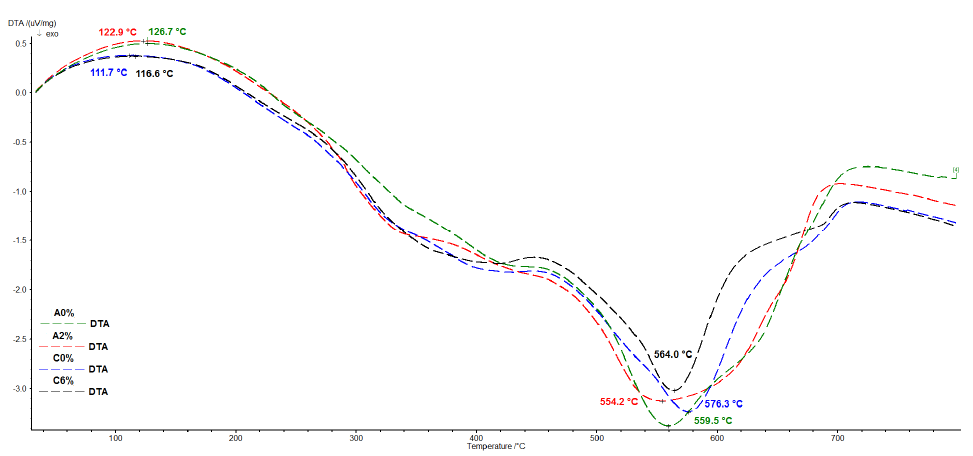
Figure 7. DTA curves for the investigated PURs.